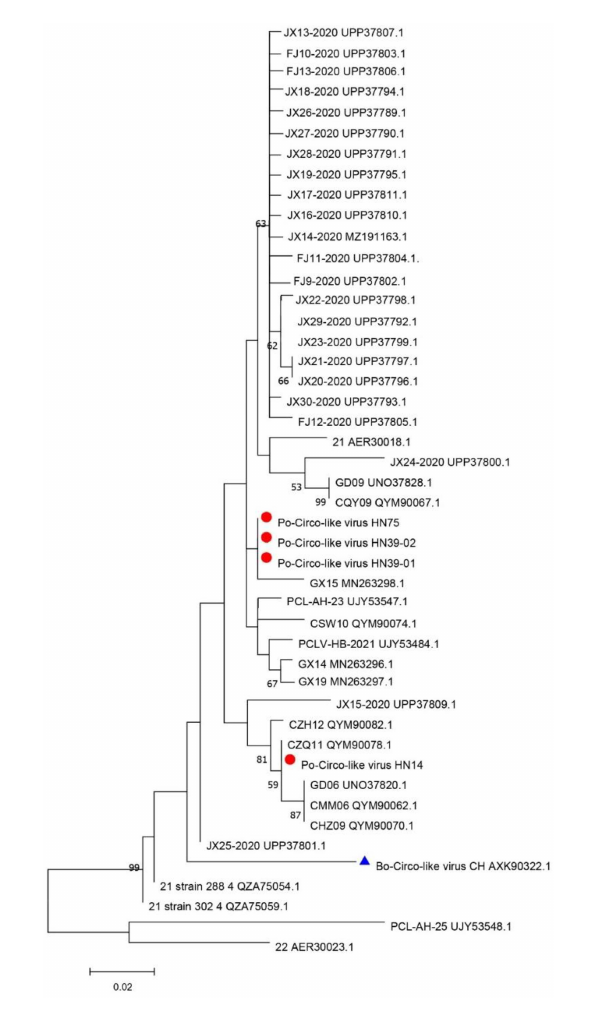
FIGURE 2 Phylogenetic trees based on the rep gene sequences of the Po- Circo-like virus and the Bo-Circo-like virus. The evolutionary history was inferred by using the Maximum Likelihood method based on the JTT matrix-based model, and 1,000 bootstrap replicates in MEGA 7.0 software. The percentage of trees in which the associated taxa clustered together is shown next to the branches. Red circles indicate the strains detected in this study, and blue triangle indicate the strains that were derived from